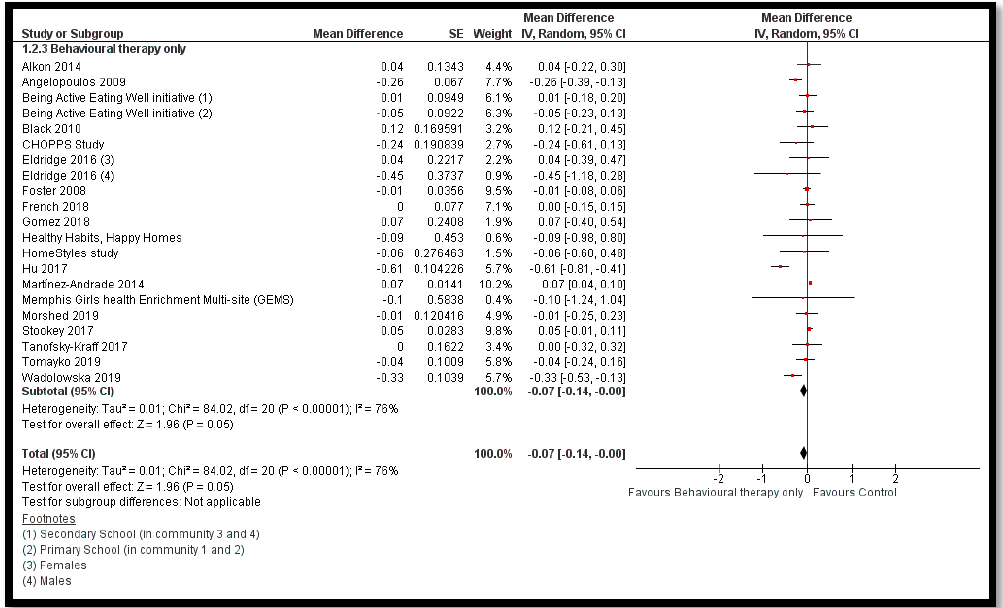
Figure 6. Forest plot for the effect of behavioural therapy interventions for obesity prevention on body mass index (BMI) z -score .